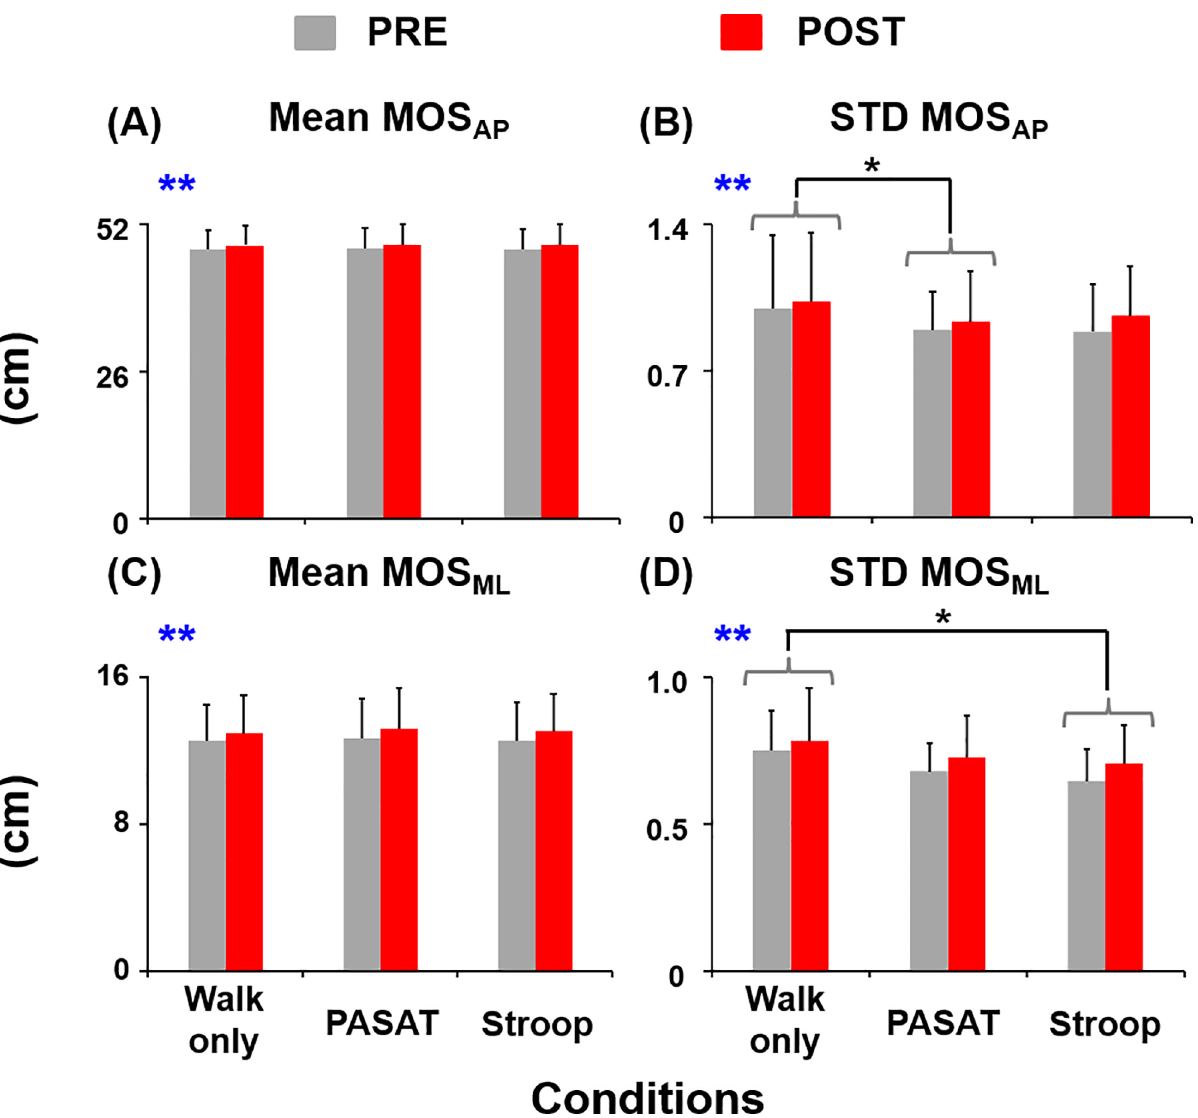
Fig 2. Margins of stability. (A) Mean and (B) variability of MOS AP , and (C) mean and (D) variability of MOS ML before (PRE, grey bars) and after (POST, red bars) the exercise session. Error bars represent 1 STD. (cid:3)(cid:3) indicates significant difference between the PRE and POST. (cid:3) indicates significant difference from the walking only condition (THSD, p <